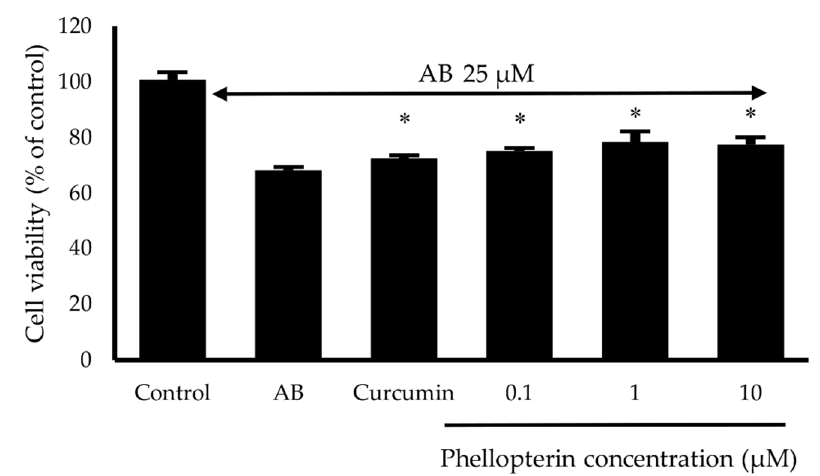
Figure 6. E ff ects of phellopterin at the concentration of 0.1 to 10 µ M on A β 1–42 -induced cell damage Figure 6. Effects of phellopterin at the concentration of 0.1 to 10 µM on A β 1–42 -induced cell damage in in SH-SY5Y cells. Curcumin at 10 µ M was used as a reference standard. The values are reported as SH-SY5Y cells. Curcumin at 10 µM was used as a reference standard. The values are reported as mean mean ± SD ( n = 3). Paired t-test, * p < 0.05 compared to A β 1–42 treated ± SD ( n = 3). Paired t-test, * p < 0 . 05 and ** p < 0.01 compared to A β 1–42 treated group.